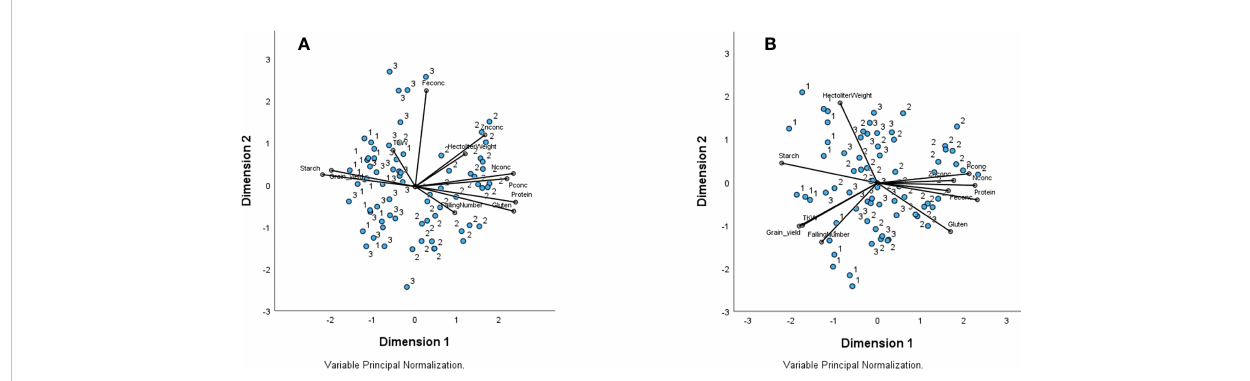
FIGURE 1 Biplot containing grouping of variables according to Principal component analysis (PCA) for 2018 (A) and 2019 (B) datasets. The variables are the trait values measured on three different wheat type groups: 1 - High yield, 2 - Organic high protein, and 3 – Intermediate for nine wheat varieties fi eld- trial in Sweden. In 2018 the total Eigenvalue was 5.7 for dimension 1 (explanatory power 57%) and 1.5 for dimension 2 (explanatory power 15%). For 2019 the total Eigenvalue was 6.2 for dimension 1 (explanatory power 62%) and 1.5 for dimension 2 (explanatory power 15%). Traits Grain yield,